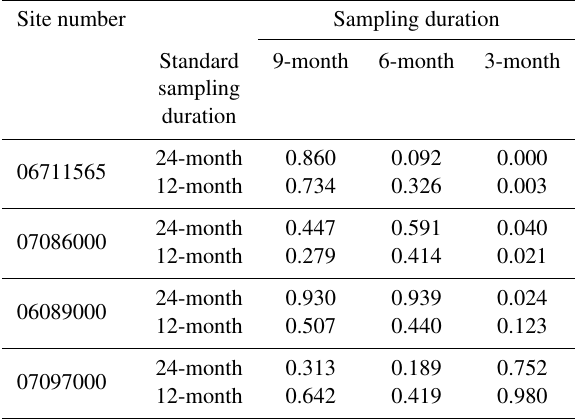
Table 2. Differences between the baseflow index (BFI) obtained from 3, 6, or 9 months of data and the BFI obtained from standard sampling